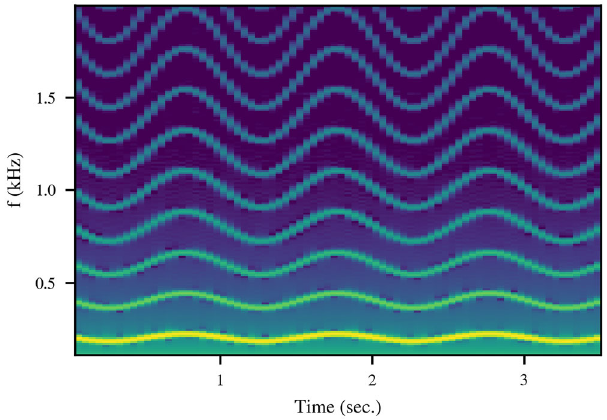
FIG. 23. The impact of a low-frequency excitation on a harmonic dipolar excitation described in Eq. (B1) for a funda- mental frequency f 0 ¼ 100 Hz.